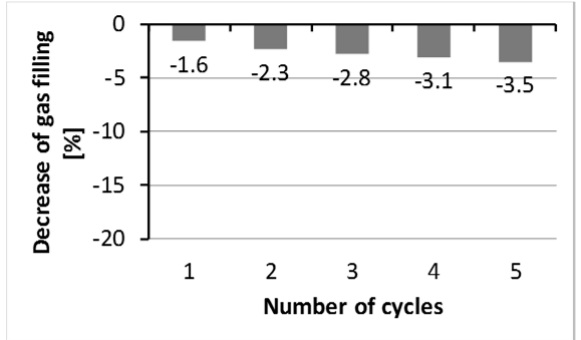
Fig. 25 Decrease of Ar-content after multiple EN1279p2 climate loads